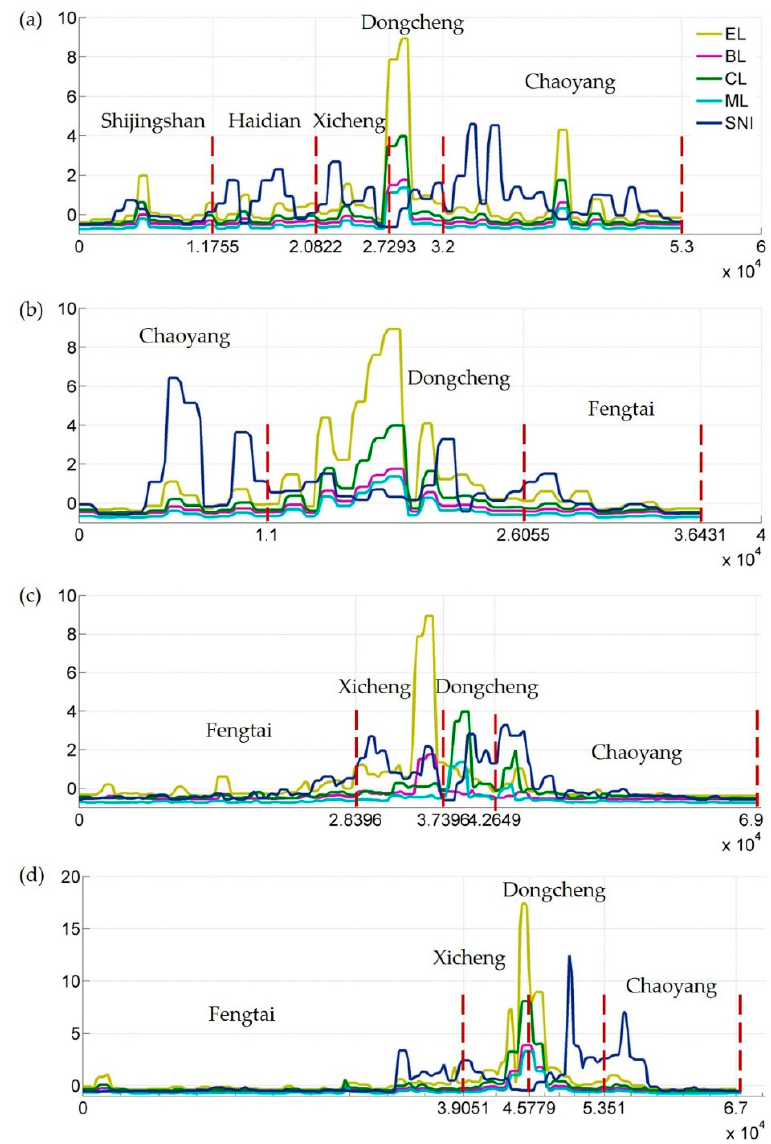
Figure 7. Results of gradient analysis of SI and SNI along four transects: ( a ) west-east, ( b ) north-south, ( c ) southwest-northeast, and ( d ) northwest-southeast in Beijing.